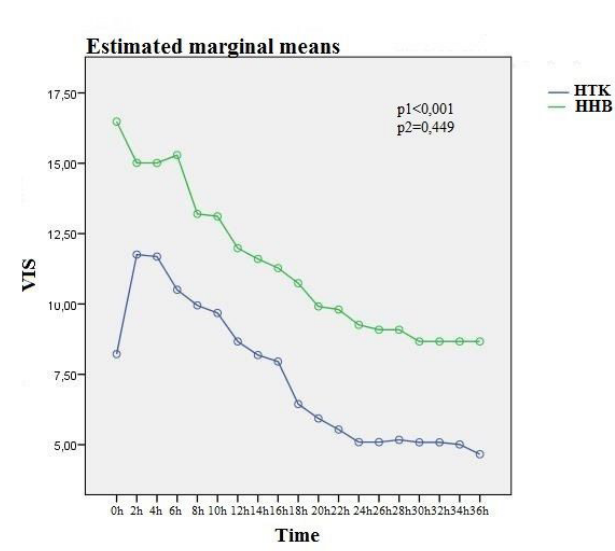
Fig. 3 – Variation of vasoactive-inotropic score (VIS) in time (P1) and between groups